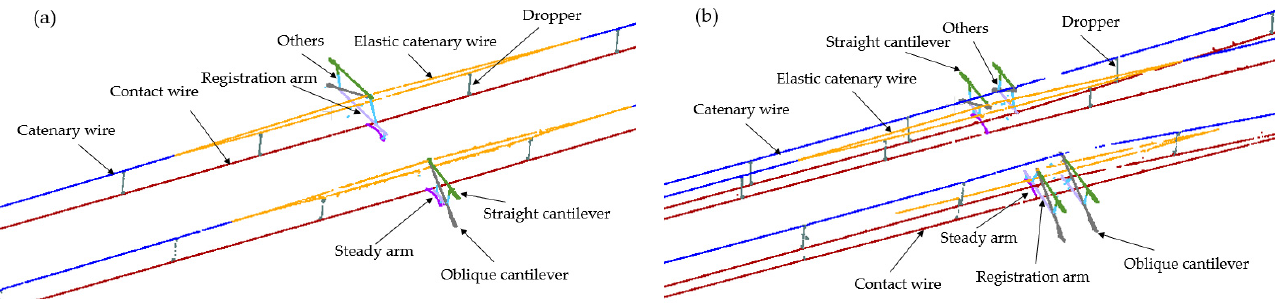
Figure 6. Component diagram of the OCS: ( a ) is the single-arm OCS and ( b ) is the double-arm OCS. Table 1. Data distribution introduction in the OCS